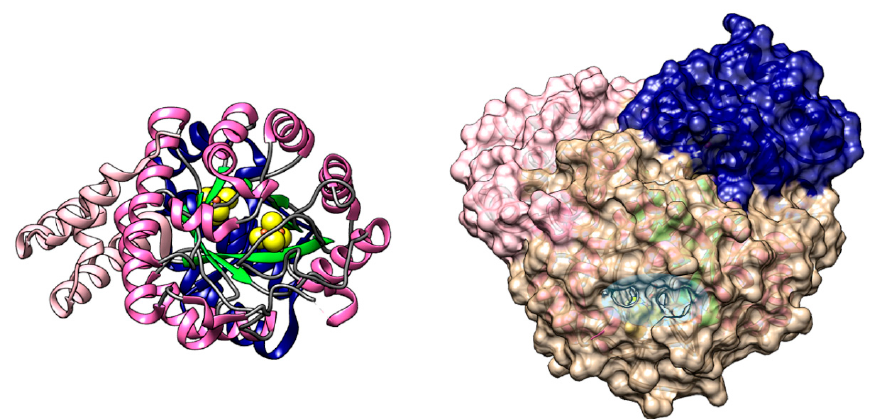
Figure 3. HydG (pdb.id 4WCX) from T. italicus. Left, cartoon representation of the protein, in the figure we show the protein from the top of the internal cavity. In magenta (helix) and green (strand) the TIM-barrel fold; in pale pink the N-terminal helices; in dark blue (on the other side of the protein) the C-terminal domain; and the [4Fe-4S] and [5Fe-4S] clusters forming the two active sites at the opposite sides of the cavity are in sphere representation. Right, a rotated view of the protein with the surface shown: the access to the internal cavity is in the center shaded in light